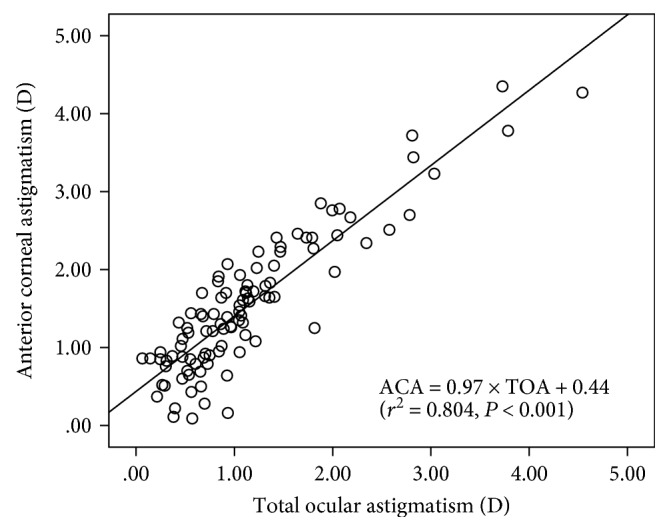
Correlation between the meridional polar value AKP of anterior corneal astigmatism and total ocular astigmatism across the whole sample. The solid black line represents linear regression.